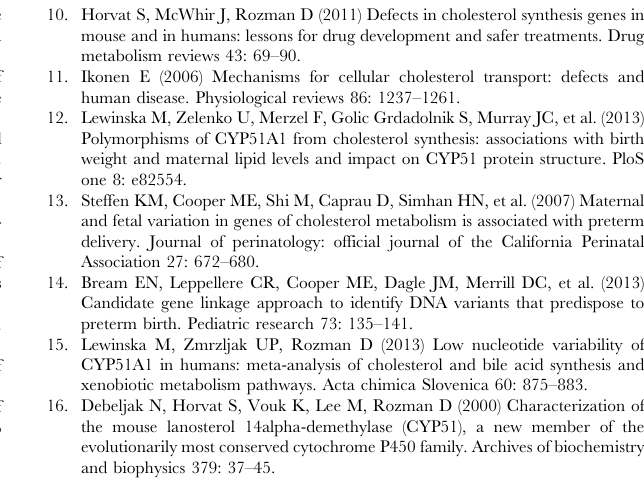
Figure S1 Outline of the statistical analysis. Figure S2 The genotype effect on hepatic gene expression and blood lipids for (A) low fat, cholesterol-free diet; (B) high fat, cholesterol-free diet; and (C) High fat with 1.25% of cholesterol added diet. The direction of arrows indicate ( q ) up-regulation or ( Q ) down-regulation of expression in heterozygous females ( R ) and males ( = ). * indicates p , 0.1 and **p , 0.05. Figure S3 The expression of Nsdhl (A) on mRNA and (B) protein levels (western blot analysis) **p , 0.05. Figure S4 The expression of Tm7sf2 (A) on mRNA and (B) DHCR14 protein levels (western blot analysis) *p , 0.1. Figure S5 The significant interactions between sex and Cyp51 genotype in mice fed with the high-fat diet with 1.25% of cholesterol - the organ characteristics and the hepatic gene expression. The interactions in organ characteristics/blood profile were not observed on cholesterol-free diets. The Dhcr24 and Abcg8 were significantly different (p = 0.06 and 0.07 respectively) on the LFnC diet and Abcg5 reached significance (p = 0.08) on the HFnC diet (data not shown). Figure S6 The significant interactions between the Cyp51 genotype and two high-fat diets with and without cholesterol.